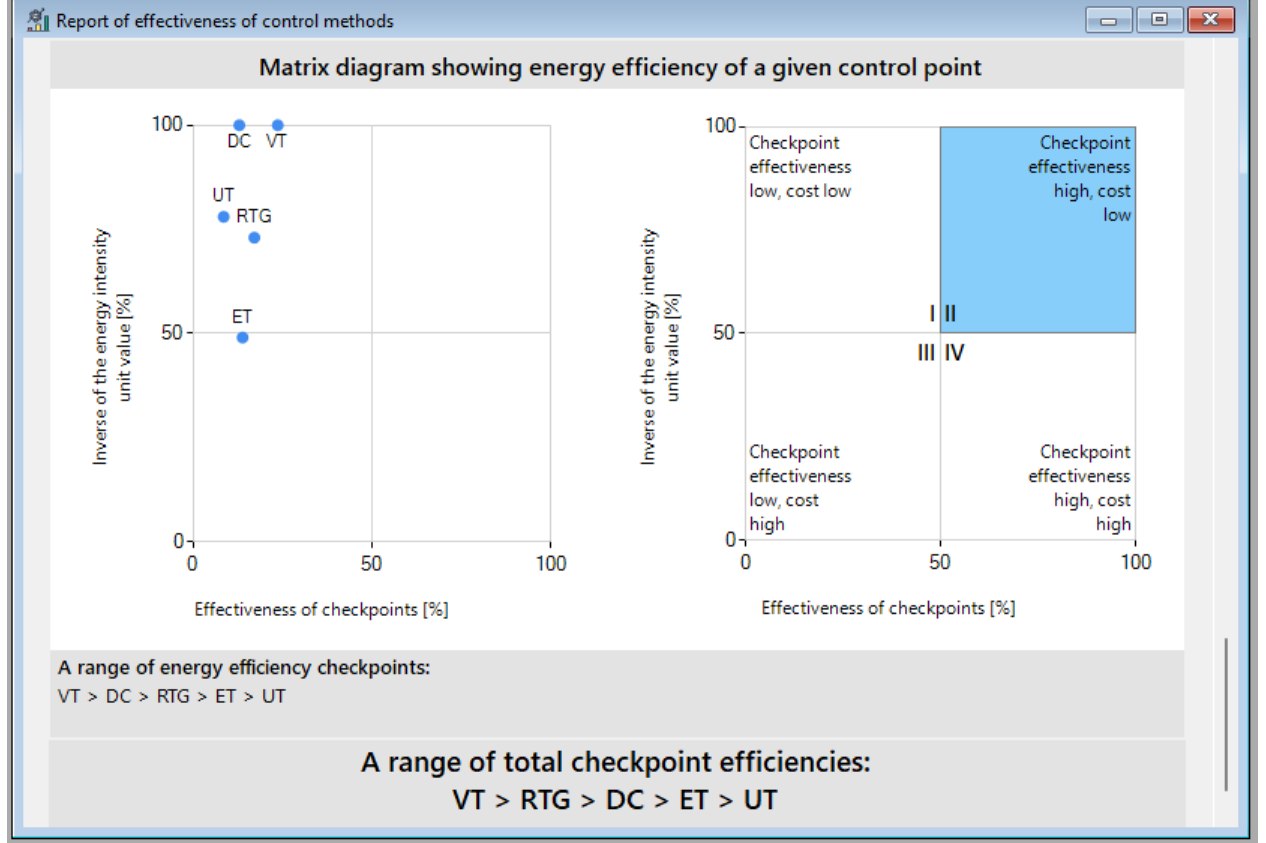
Figure 10. Part five of the control methods efficiency report—analysis of the level of energy efficiency of detection methods and ranking of the total efficiency of detection methods.